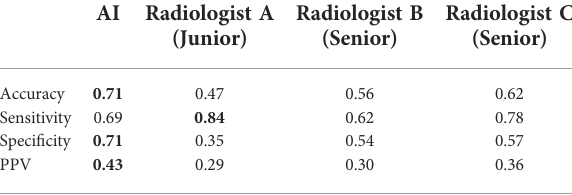
Bold values are the highest